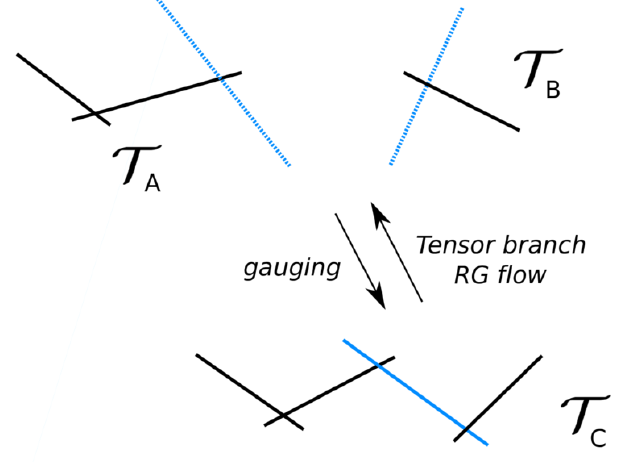
Figure 2. Schematic description of the gauging of a (generalized) (cid:13)avor symmetry in 6d SCFTs. Two models T A and T B that share the same (cid:13)avor divisor can give rise to a consistent theory T C by making the corresponding noncompact (cid:13)avor curve (dotted blue line in the (cid:12)gure) into a compact